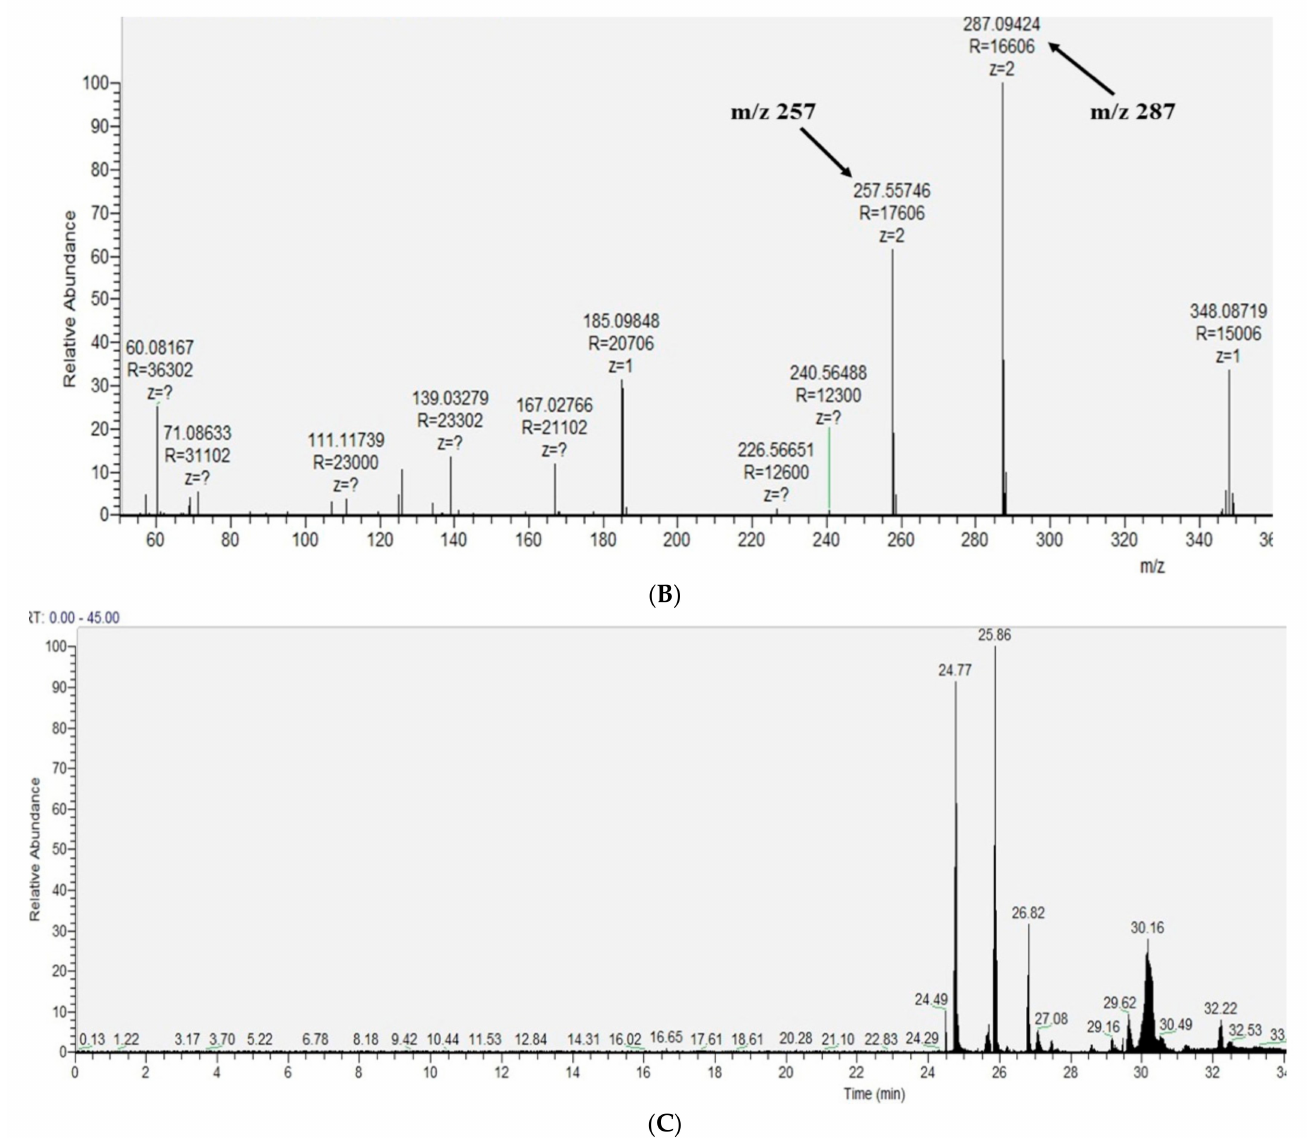
Figure 2. ( A ) Alkylated EGT in BY4741 egtA-His cell lysate. LC–MS of BY4741 egtA-His alkylated cell lysate revealed EGT presence at retention time of 24 min (A), including the double protonated form at m/z 309 (B); ( B ) daughter ions m/z 287 and m/z 257 of m/z 309 were identified also in cell lysate of BY4741 -egtA which confirmed the intracellular presence of EGT; ( C ) neither m/z 309 or m/z 617 was present in the control culture BY4741 p426-GPD , confirming EGT